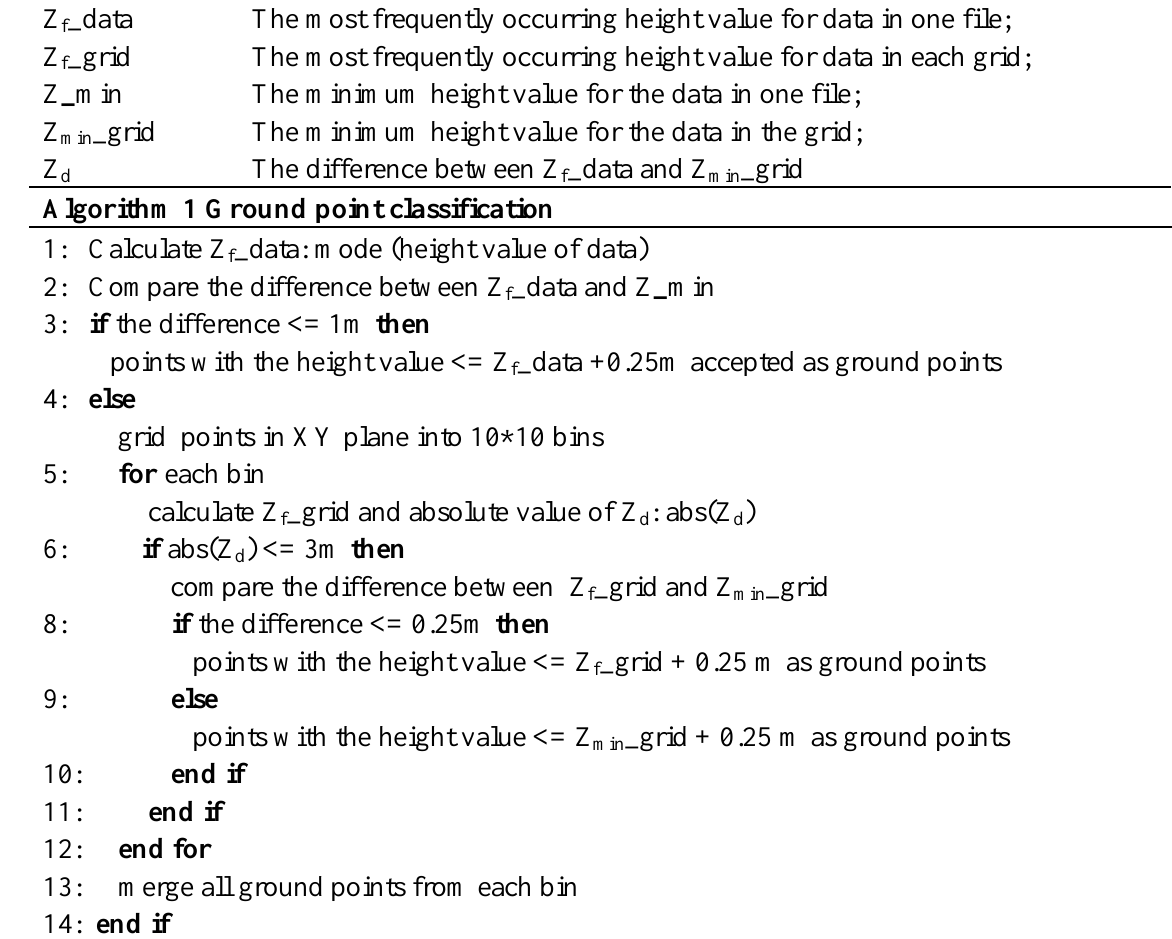
Table 2. A list of abbreviations.